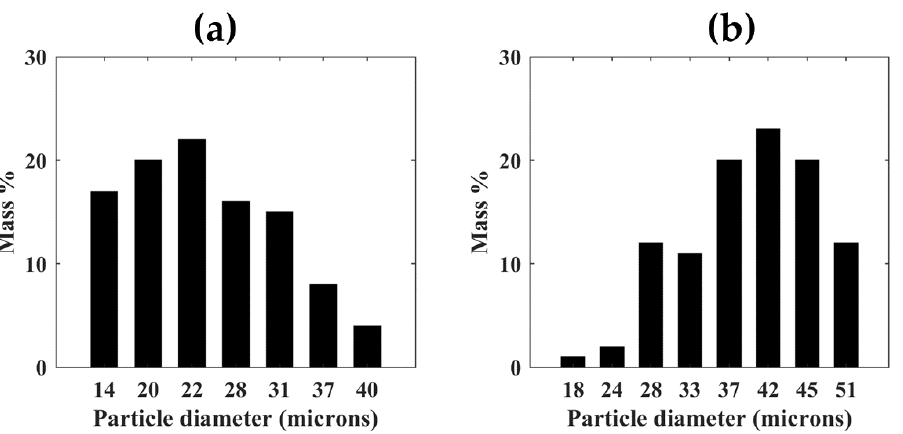
Figure 14. Particle Size Distribution (PSD) of particles leaving the dryer in case “F”: ( a ) via gas outlet; ( b ) solids outlet.